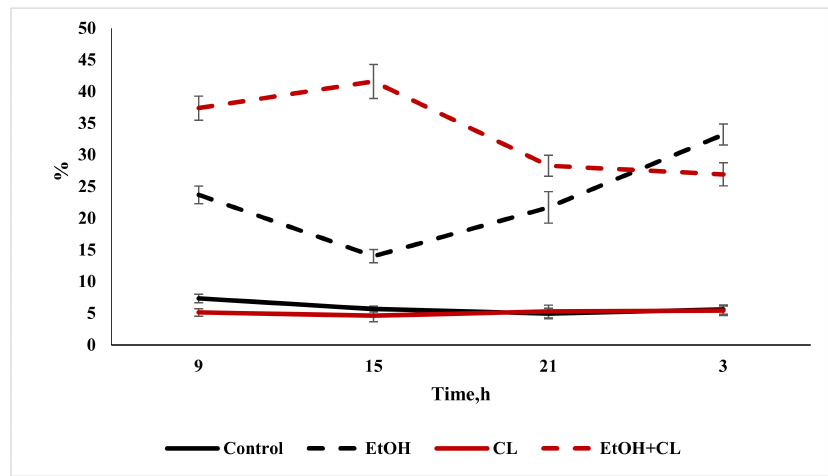
Figure 21. Daily fluctuations in the expression of Adh5 in rat